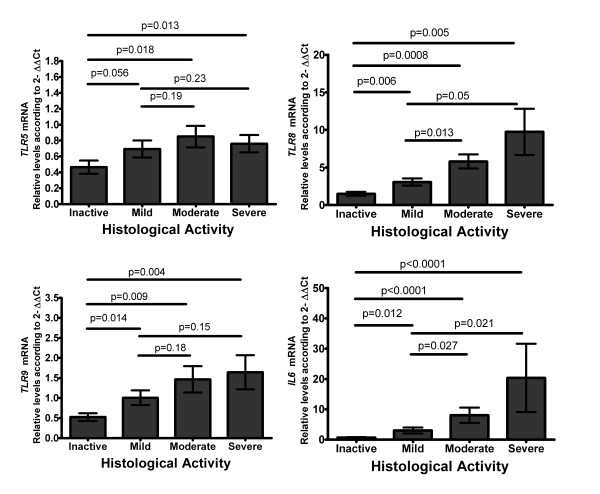
Toll-like receptors TLR5, TLR8, and TLR9 mRNA levels in Ulcerative Colitis correlate with Histological Activity. RT-qPCR was performed to assess mRNA levels in colonic mucosa biopsies from UC patients according to Riley Histological Activity, bars show means with standard error of the mean of TLRs and IL6 transcript levels with RPLP0 as housekeeping gene determined by 2-ΔΔCt, differences among groups were assessed by Mann-Whitney U test, and p values are presented in the figure.